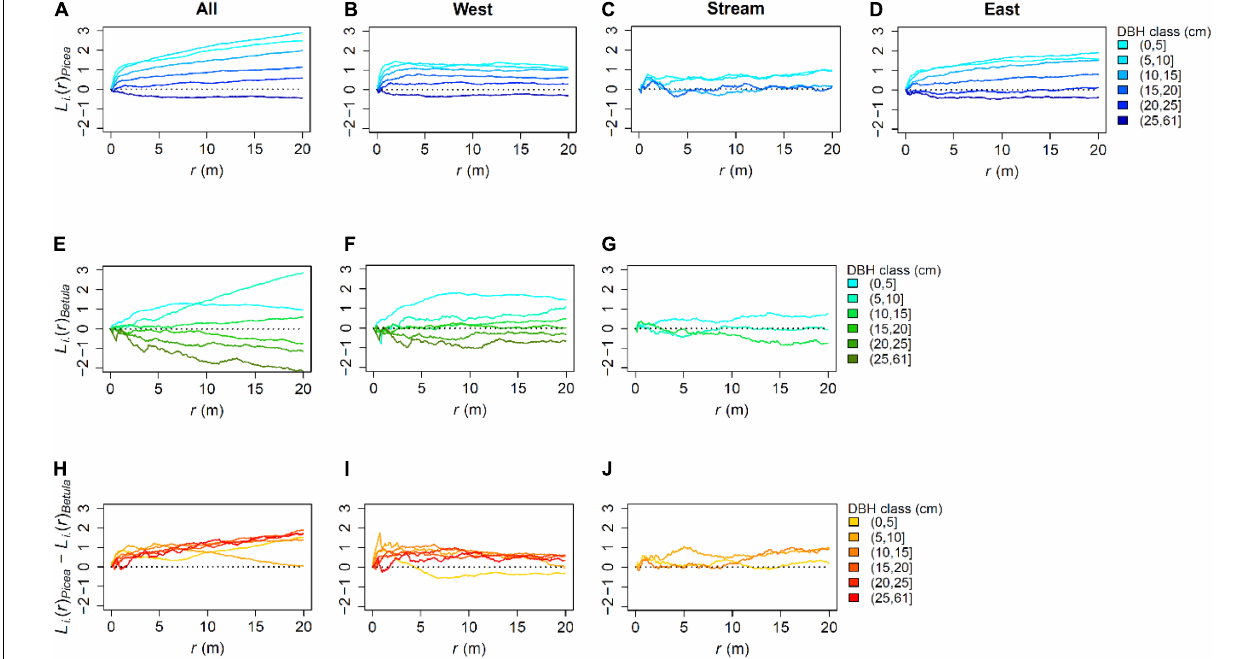
Frontiers in Forests and Global Change |